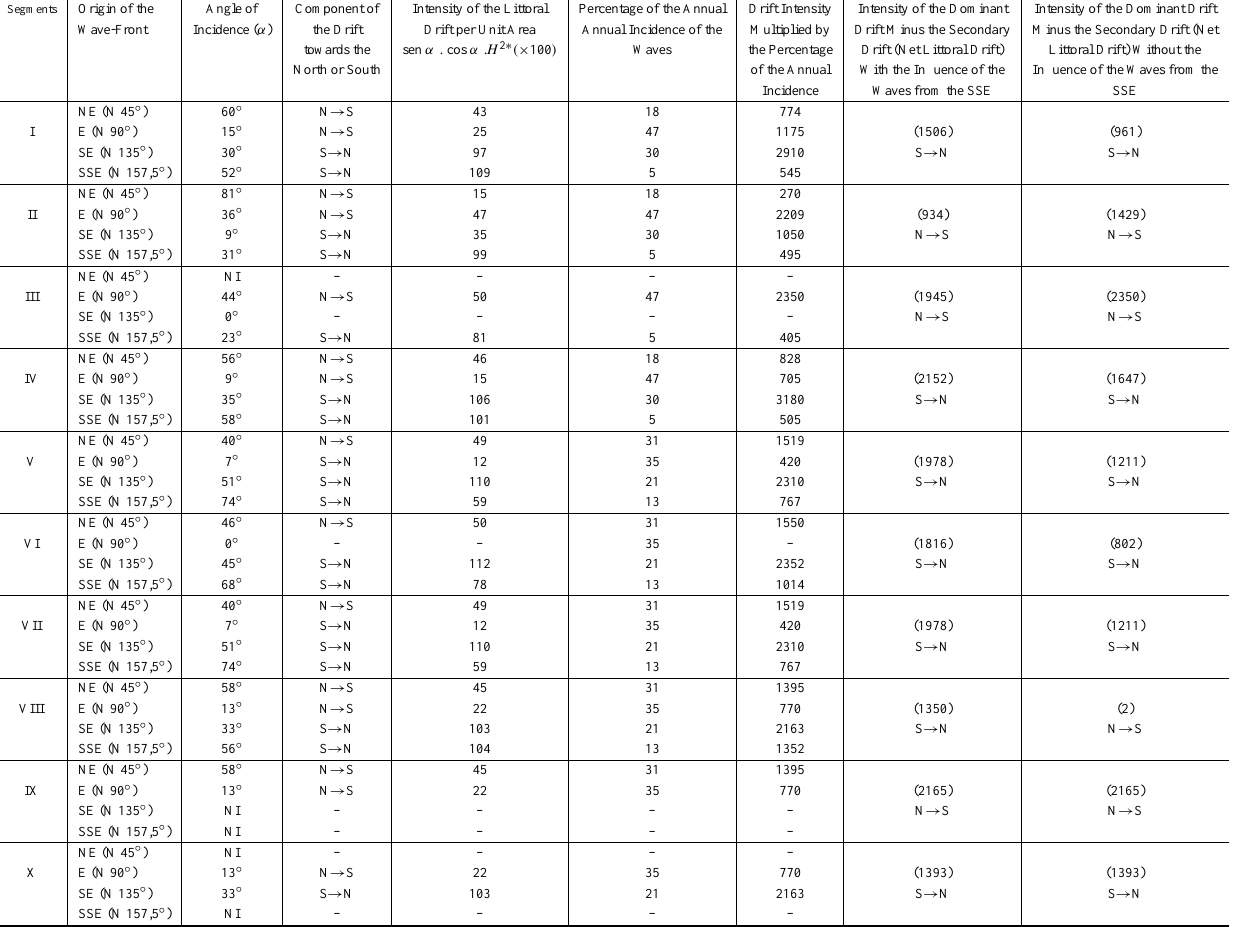
Potential intensity of the net littoral drift for the coastal Segments I through IX, calculated per unit area, with and without the influence of the SSE waves (See Figs. 5 and